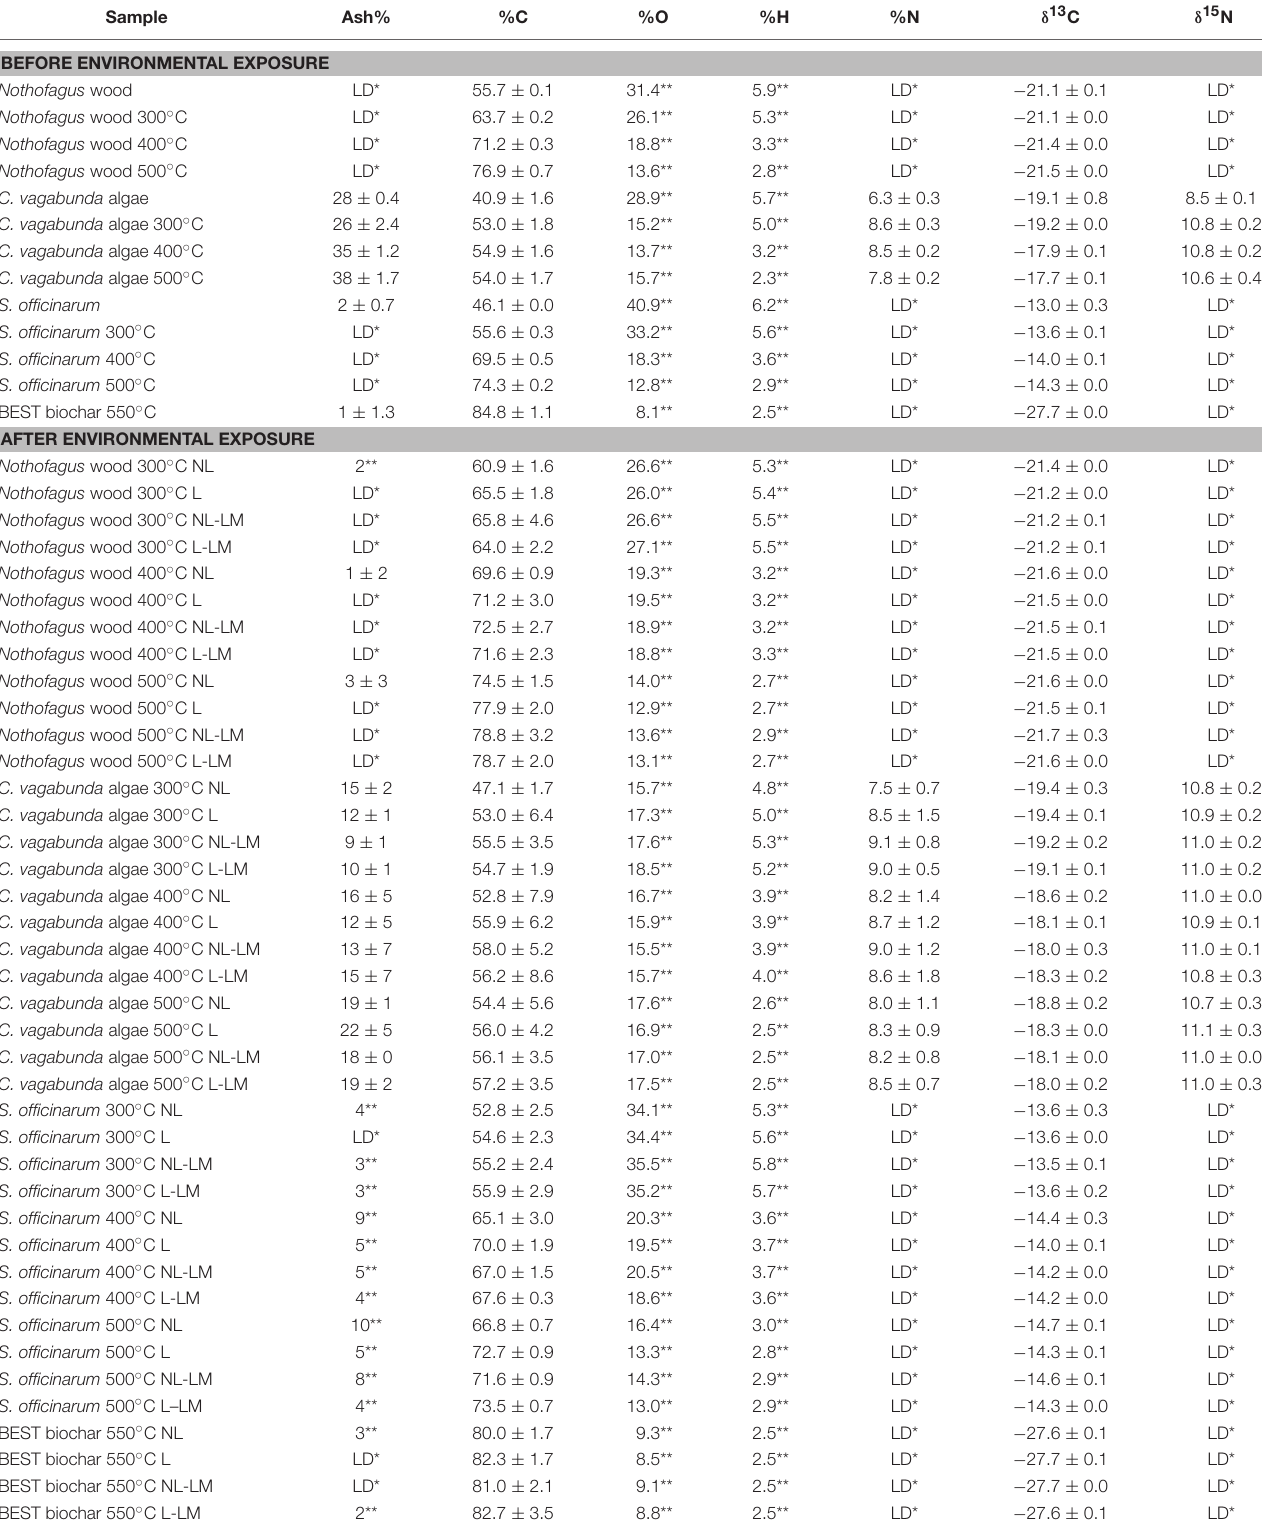
TABLE 1 | Measured ash content, elemental abundance (%C, %O, %H, %N), and stable isotope ratios ( δ 13 C and δ 15 N) before and after environmental exposure.